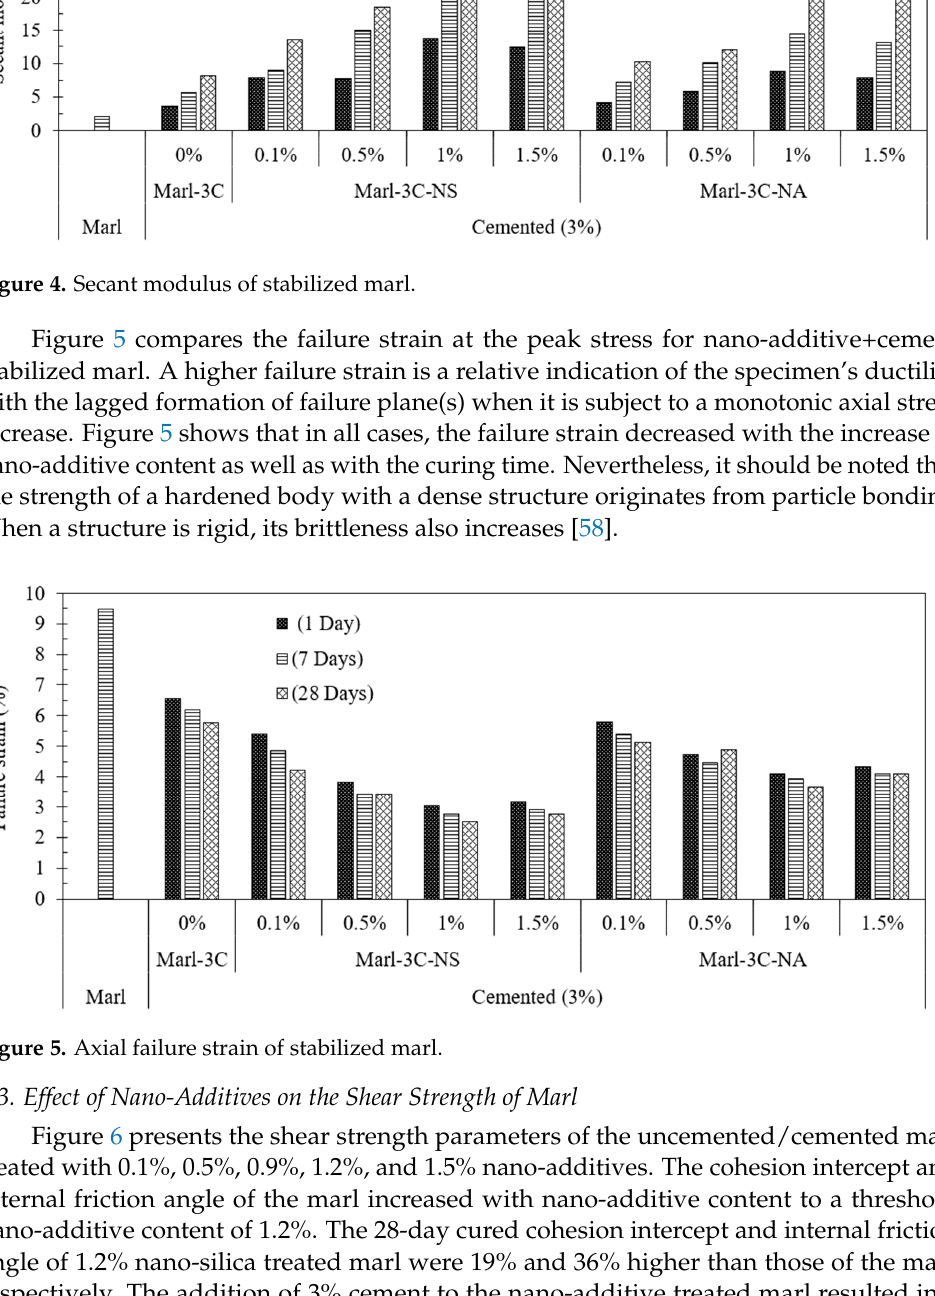
Figure 3. Unconfined compressive strength of stabilized marl.